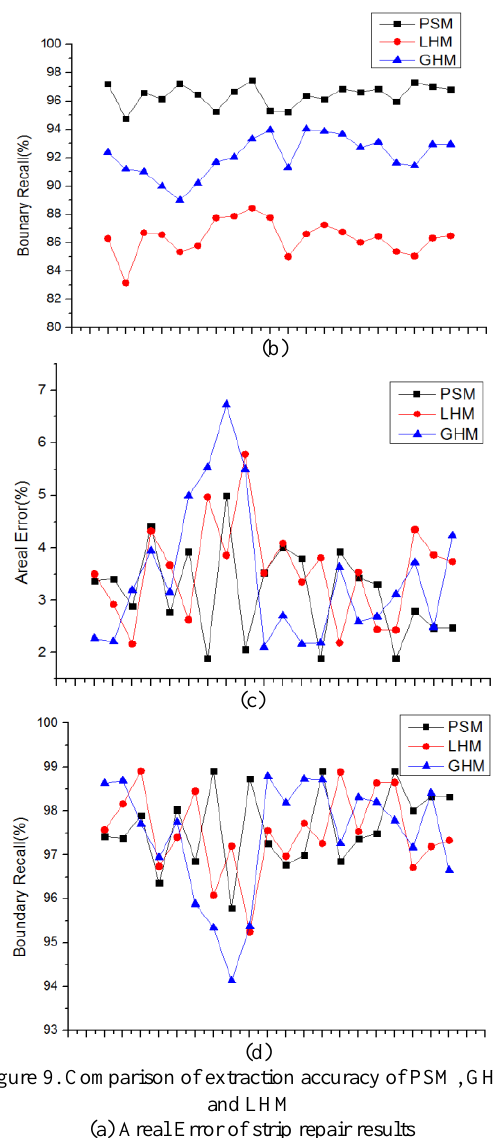
Figure 9. Comparison of extraction accuracy of PSM, GHM, and